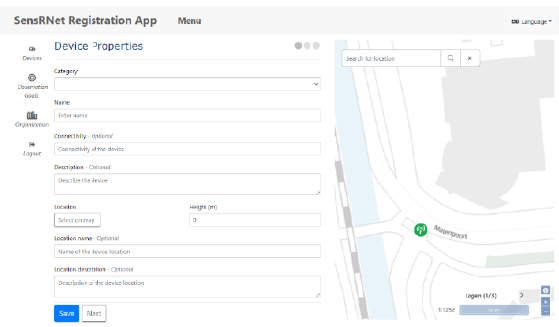
Figure 8 . A screenshot of the first page of the registration form in the Registry